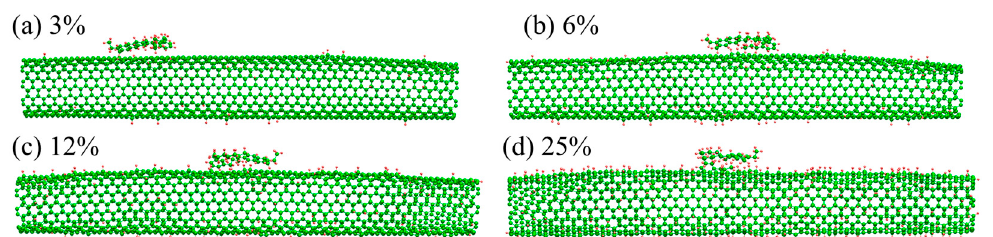
Figure 4. Molecular structure of aromatic molecule and CNTs with different hydrogenated dosage of ( a ) 3%, ( b ) 6%, ( c ) 12%, and ( d ) 25%.